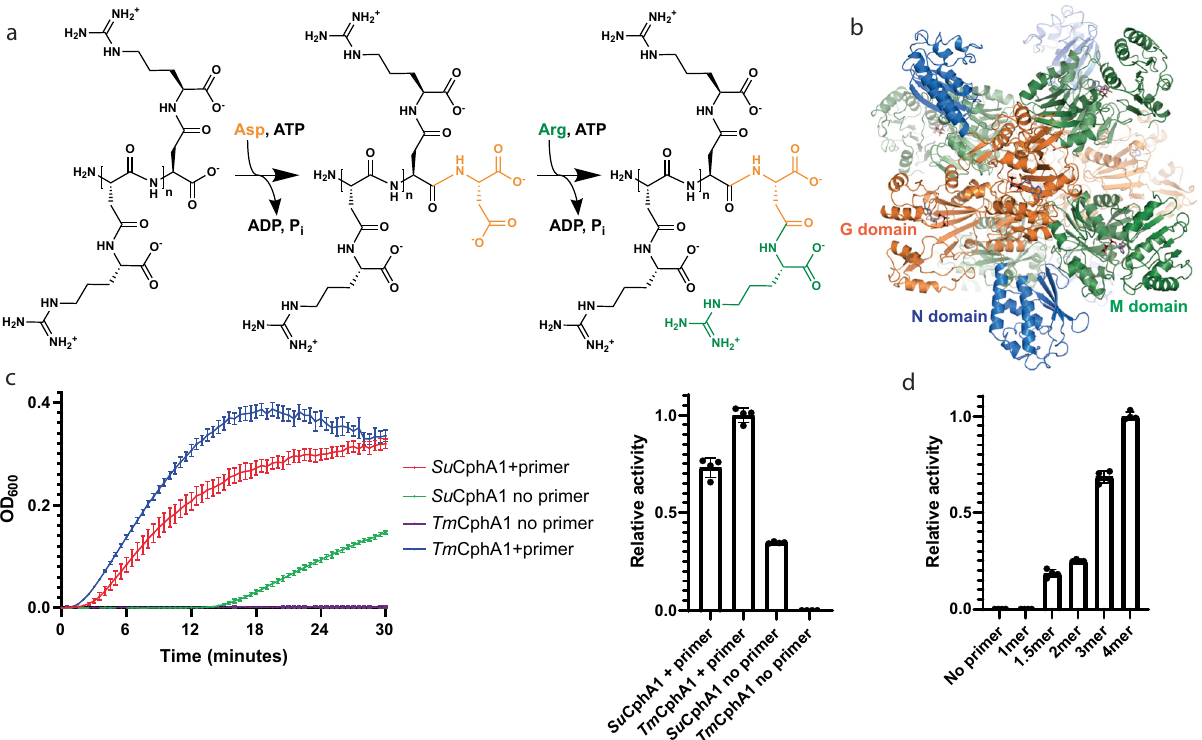
Fig. 1 CphA1 structure and activity. a Schematic diagram of the biosynthetic reactions catalyzed by the G and M domains of CphA1. b The overall structure of tetrameric CphA1 11 from Synechocystis sp. UTEX2470 ( Su CphA1, PDB code 7LG5). ATP molecules mark the positions of the G (orange) and M (green) domain active sites. The N domain is colored in blue. c Cyanophycin biosynthesis plots and rate comparison of synthesis by Su CphA1 and Tm CphA1 with and without primer. Tm CphA1 is completely inactive in the absence of primer. n = 4 independent experiments. Data are presented as individual measurements and mean value, error bars represent SD values. d Activity levels of Tm CphA1 in the presence of various cyanophycin primers: 1mer ( β -Asp- Arg) 1 , 1.5mer ( β -Asp-Arg)-Asp, 2mer ( β -Asp-Arg) 2 , 3mer ( β -Asp-Arg) 3 , 4mer ( β -Asp-Arg) 4 . n = 4 independent experiments. Data are presented as individual measurements and mean value, error bars represent SD